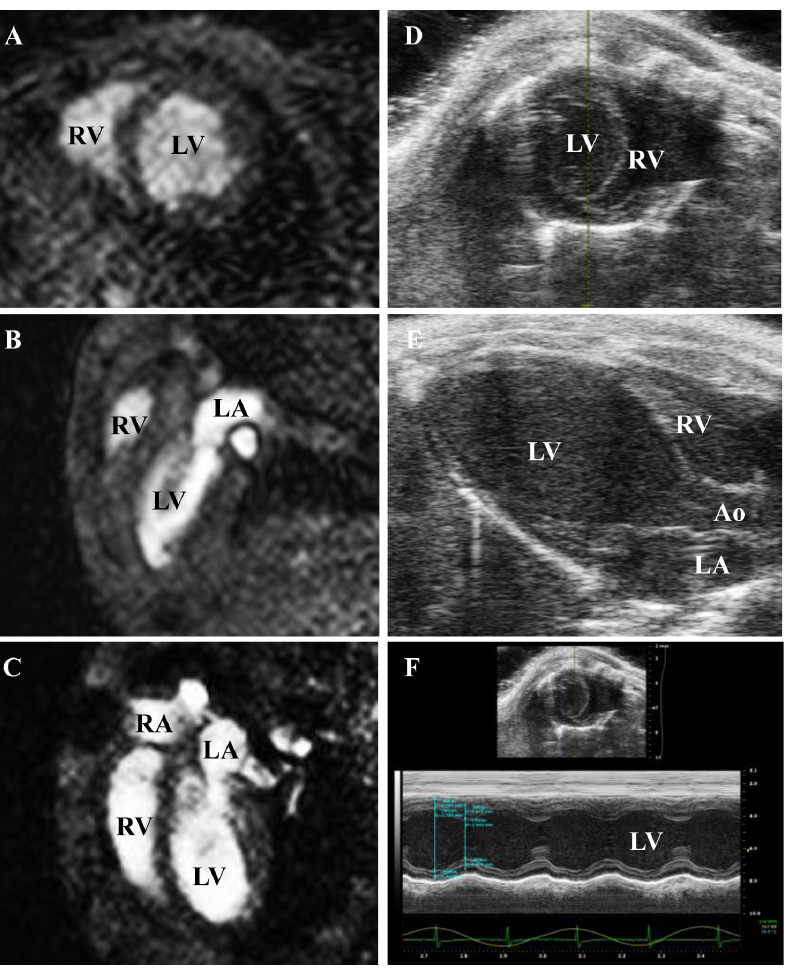
Figure 1. Representative slides of MRI and echocardiography-gained heart slides. Short axis view gained with A) MRI and D) echocardiography. Seven short axis slices were used for calculation of left ventricular volumes with MRI. B) Shows MRI-gained and E) echocardiography-gained long axis view. C) Shows 4-chamber view (MRI). F) Shows M-mode based calculation of LVEF (echocardiography). LV: left ventricle; RV: right ventricle; LA: left atrium; RA: right atrium; Ao: aorta.